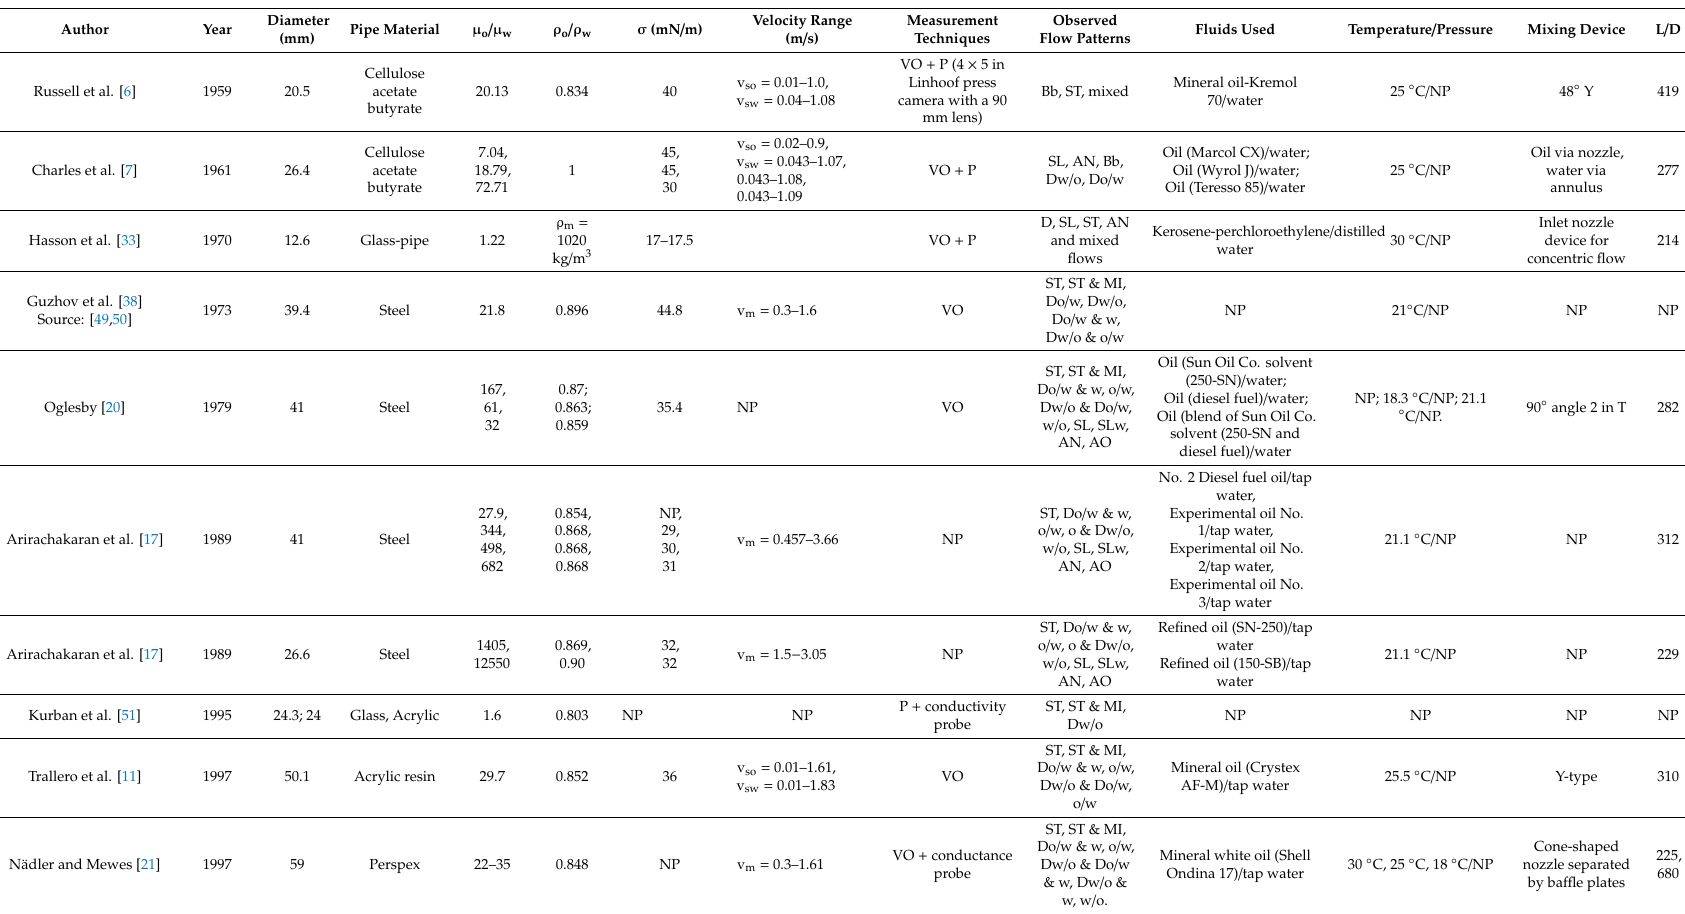
Table 2. Experimental works on oil-water flow patterns in horizontal